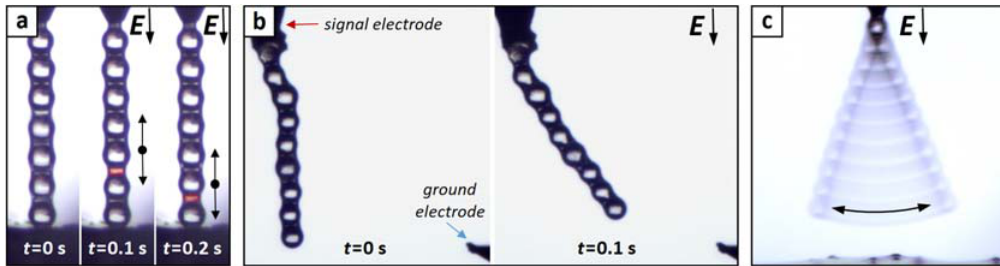
Figure 6. ( a ) Demonstration of contact-charge electrophoresis. A particle chain is placed between the signal electrode and a grounded plate. The distance between the electrodes is larger (around a one-particle radius) than the sum of the particle diameters comprising the chain. This distance enables particle motion along the chain direction. A DC electric field is turned on ( t > 0 s) and some of the particles oscillate up and down, as indicated by the arrows. Large gaps between particles are marked with red color. See also corresponding Movie S5; ( b ) Active bending of a particle chain. When a DC electric field is applied, the chain bends towards the ground electrode. The bending is permitted due to the chain flexibility caused by liquid bridges between particles. The chain movement is reversible by turning off the electric field. See also corresponding Movie S6; ( c ) Oscillation of a granular chain. The particle chain oscillates with a frequency of more than 25 Hz when subjected to a voltage around 300 V and frequency of 50 Hz. The oscillations stop after increasing the frequency to 200 Hz. See also corresponding Movie S7.